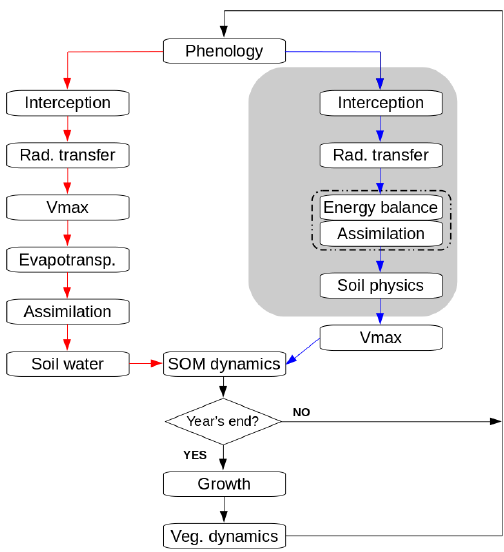
Figure 1. Flowchart of the main daily simulation loop in stan- dard LPJ-GUESS (red branch) and the modified version (LPJ- GUESS/LSM, blue branch). The shaded area indicates the sub-daily loop in the modified version. The dashed line encloses coupled iter- ative